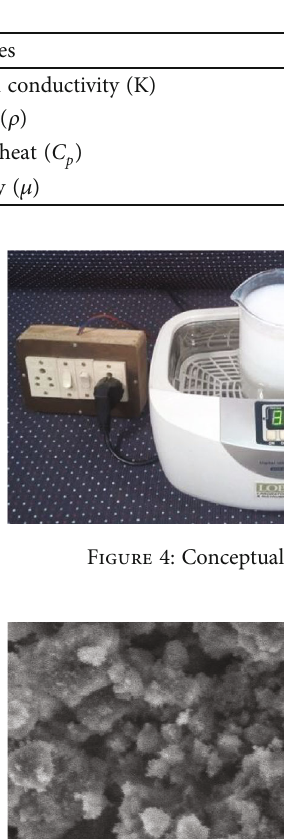
Table 2: Properties of working fl uids.